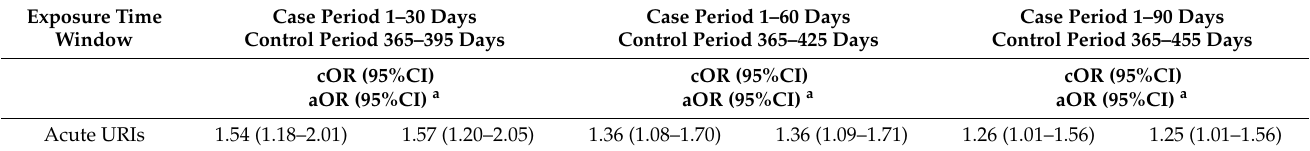
Table 3. Sensitivity Analysis of Various Exposure Time Windows for Acute URIs and SSNHL Risk. Exposure Time